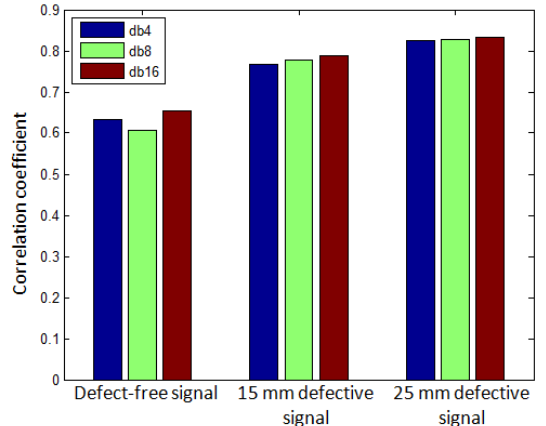
Figure 7. Comparison of maximum correlation coefficients between the 8th level detailed signal by using Daubechies (db4, db8, and db 16) mother wavelet to the original signals.